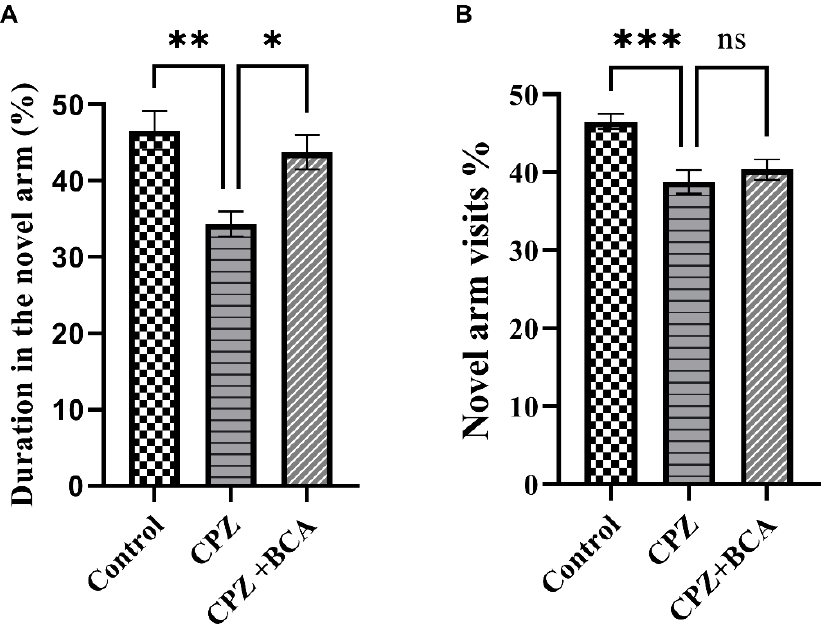
Figure 5. Novel arm discrimination task (NADT). ( A ) Percentage of time in the novel arm: CPZ significantly decreased the duration in the novel arm whereas BCA significantly increased the duration spent in the novel arm compared with the CPZ. ( B ) Percentage of novel arm visits: CPZ significantly decreased the percentage of the novel arm visits compared with the control group, while there was no significant effect of BCA on the percentage of novel arm visits. Data are presented as mean ± SEM. One-way ANOVA followed by Tukey’s test was used. ns = non-significant, * p < 0.05, ** p < 0.01, *** p < 0.001. (CPZ: cuprizone, BCA: biochanin A).